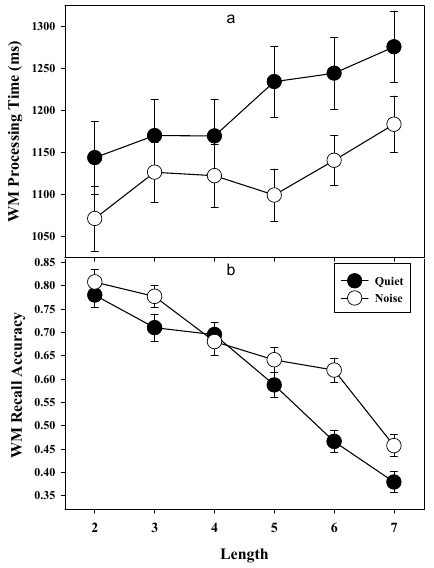
Figure 2. Mean processing time (panel ( a )) and recall accuracy (panel ( b )) for the working memory task by condition and set length. Error bars depict one standard error of mean. WM = Working memory.